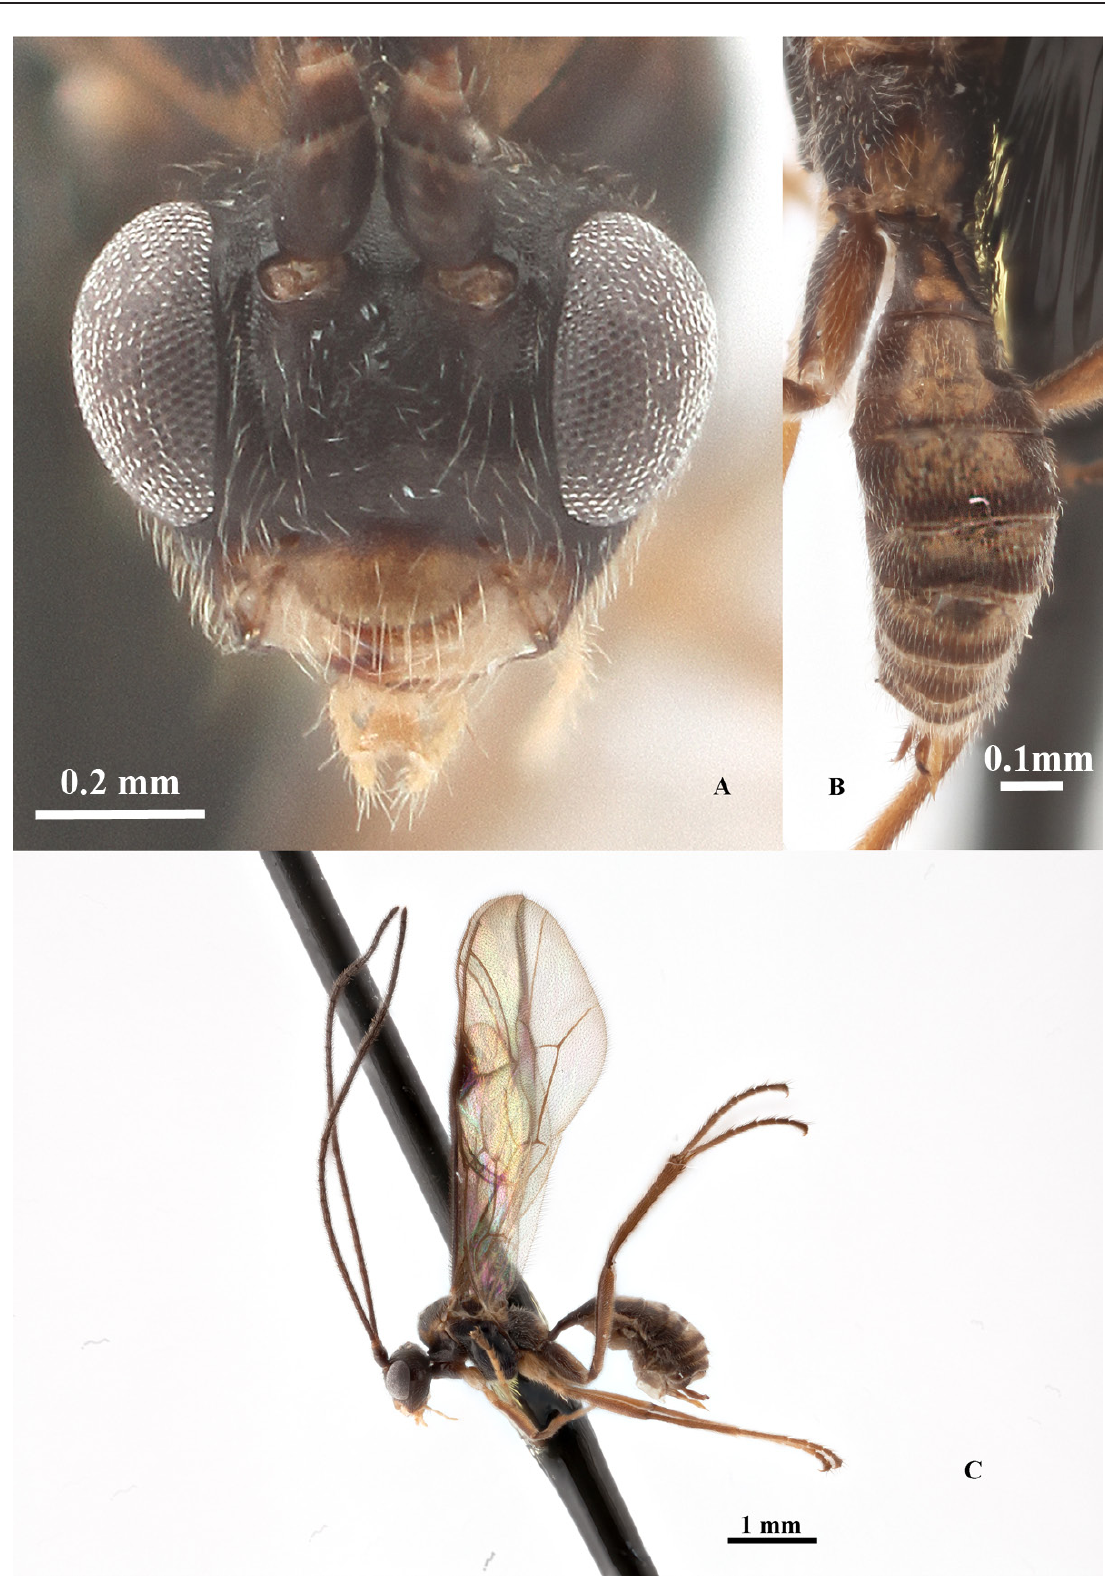
Fig. 5 . Nanium medianum Reshchikov & Sääksjärvi sp. nov. , holotype, ♀ ( EC/2009-37/ MP&ADB-013 (RBINS)) . A . Face. B . Metasoma (dorsal view). C .